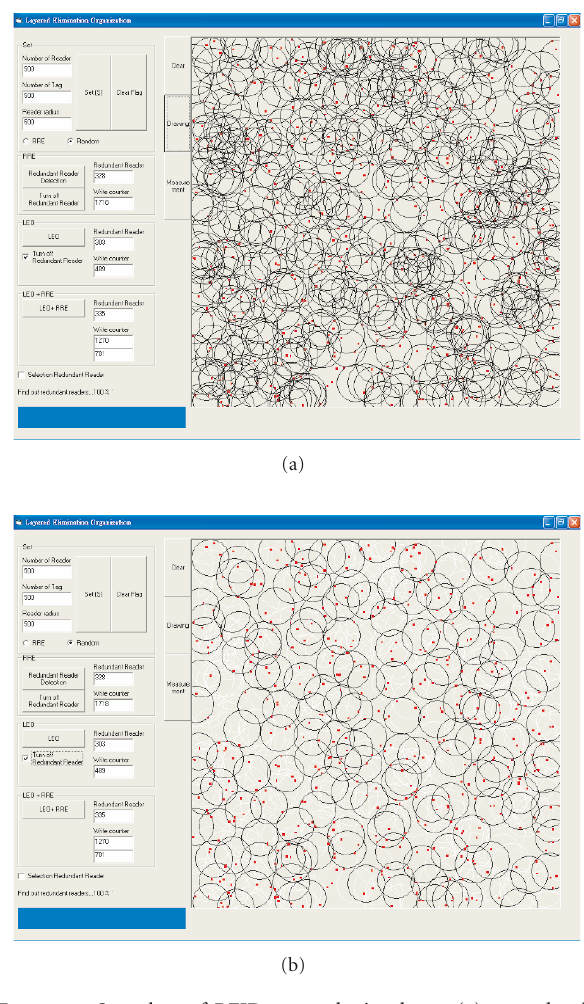
Figure 7: Snapshot of RFID network simulator: (a) a randomly generated RFID network, (b) network topology after redundant readers are removed.